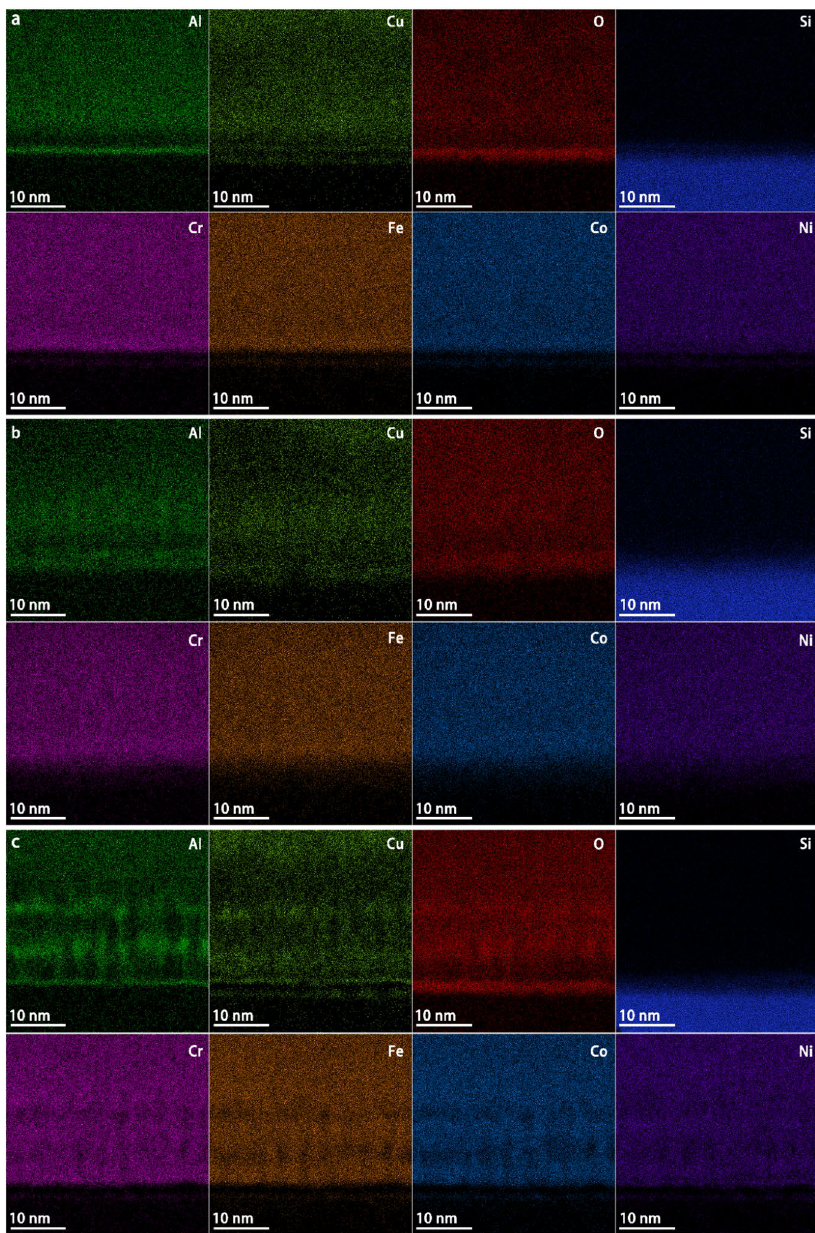
Figure 6. Cross-sectional EDS map of each element at the interface of the AlCrFeCoNiCu0.5 HEA thin films with the substrate at different substrate bias. ( a ) maps with 0 V bias, ( b ) maps with −50 V bias, and ( c ) maps with −100 V